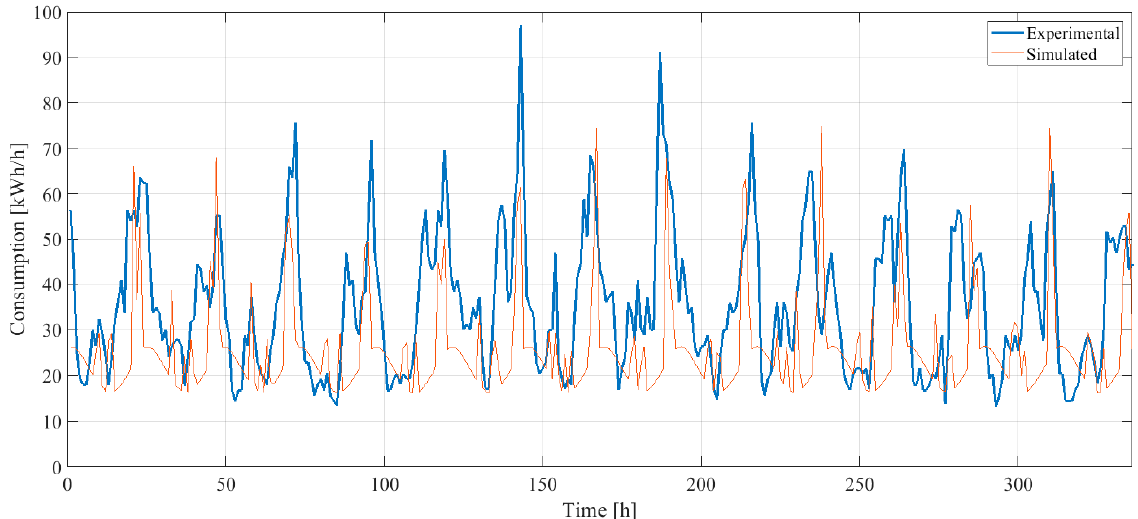
Figure 10. Comparison between the experimental and simulated load curves during 14 days (1st to 14th of December 2021).